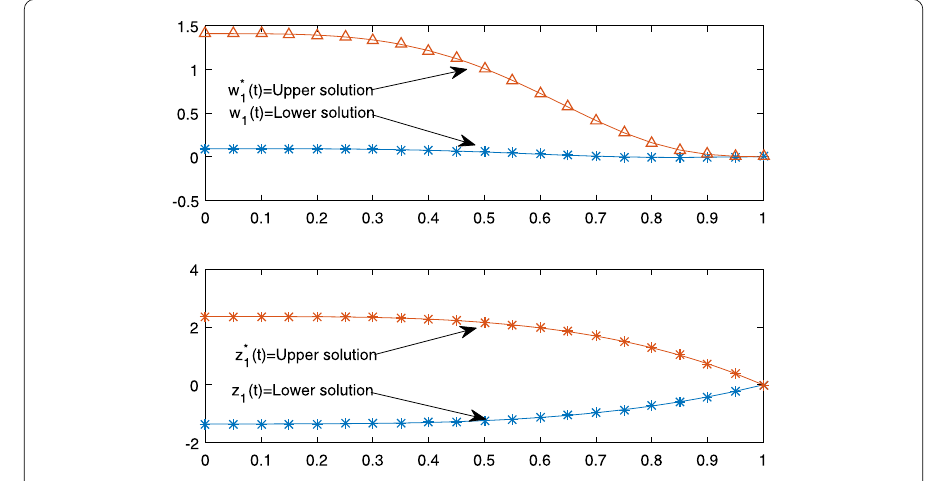
Figure 3 A line graph of the solutions of Example 5.2